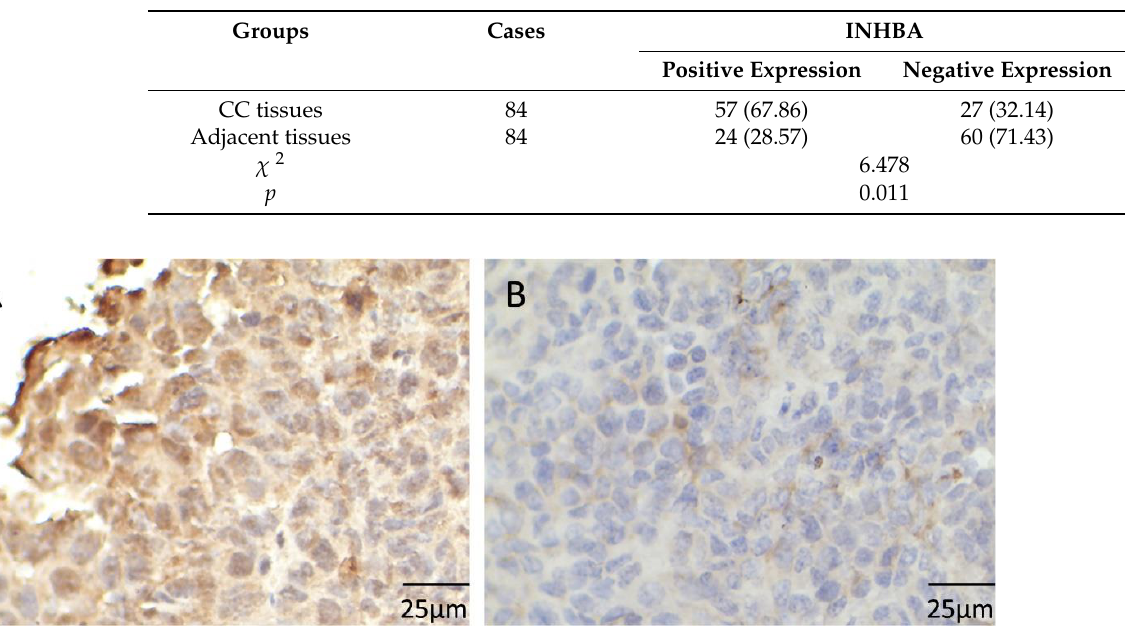
Figure 2. Detection of inhibin beta A (INHBA) expression in cervical cancer (CC) tissues by immunohistochemistry (IHC) (×400). ( A ) Positive INHBA expression; ( B ) Negative INHBA expression.